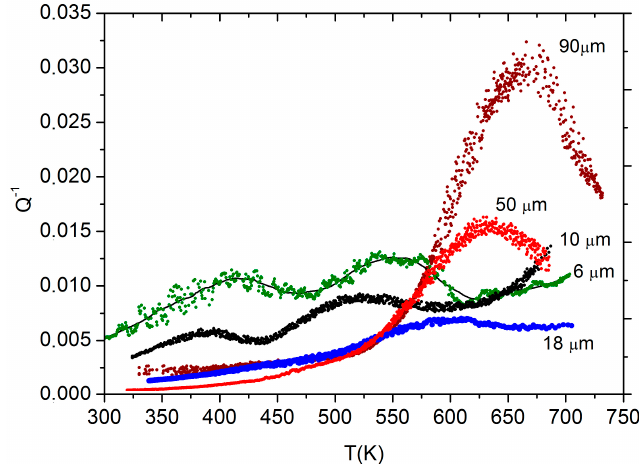
Figure 6. Q − 1 vs. temperature curves of free-standing specimens with thicknesses of 90 µ m (magenta), 50 µ m (red), 18 µ m (blue), 10 µ m (black), and 6 µ m (green). The black line is just a guide for the eye. Resonance frequencies are about 250 Hz.